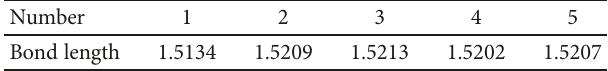
Table 3: Simulated results of bond length by HyperChem.